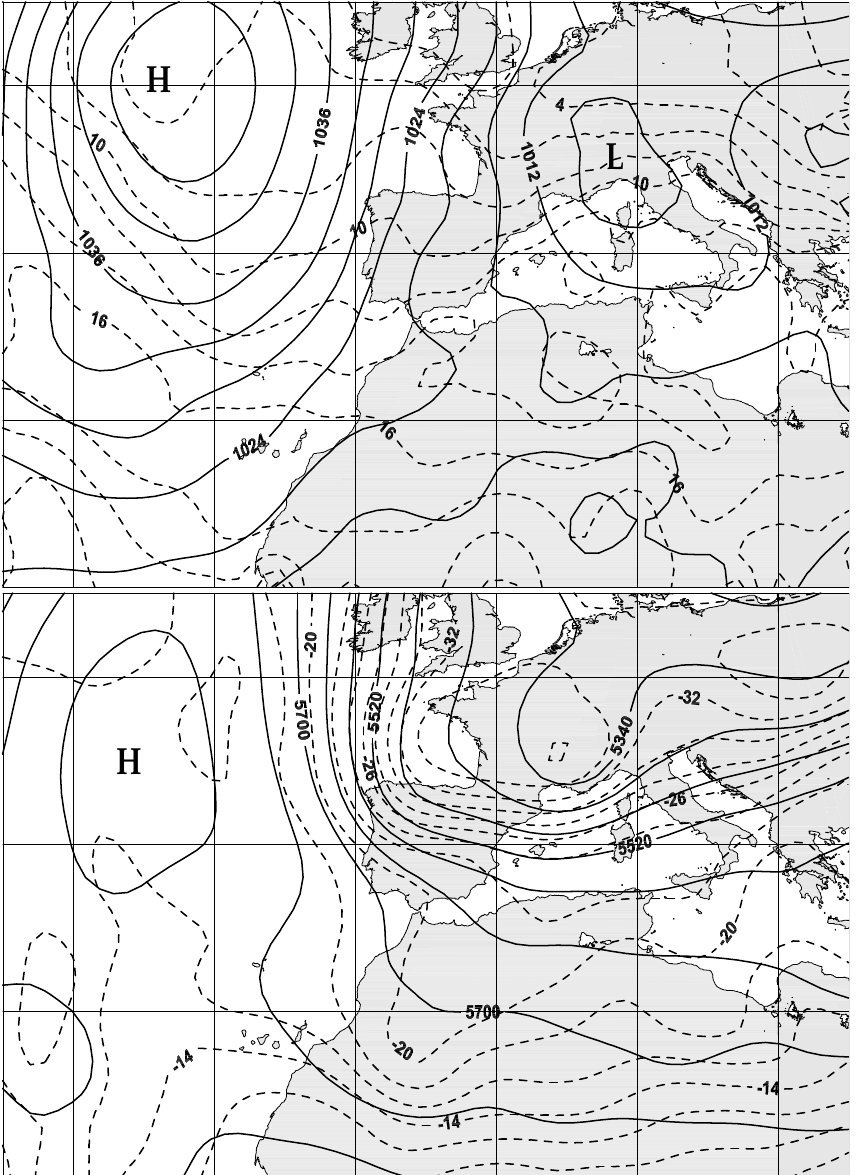
Fig. 3. Synoptic situation from the ECMWF reanalysis at 12:00UTC, 19December1979. (a) Surface pres- sure (hPa, solid line) and tempera- ture ( ◦ C, dashed line) at 1000hPa, (b) Geopotential height (gpm, continu- ous line) and temperature ( ◦ C, dashed line) at